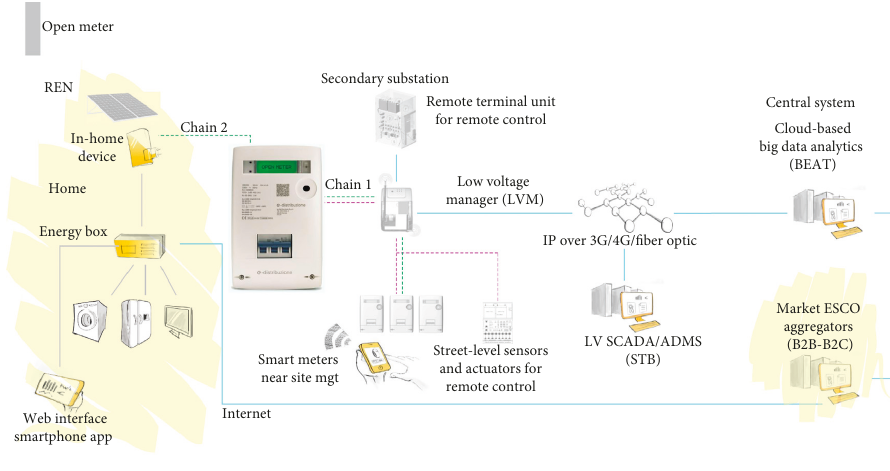
Figure 1: Telegestore system architecture.